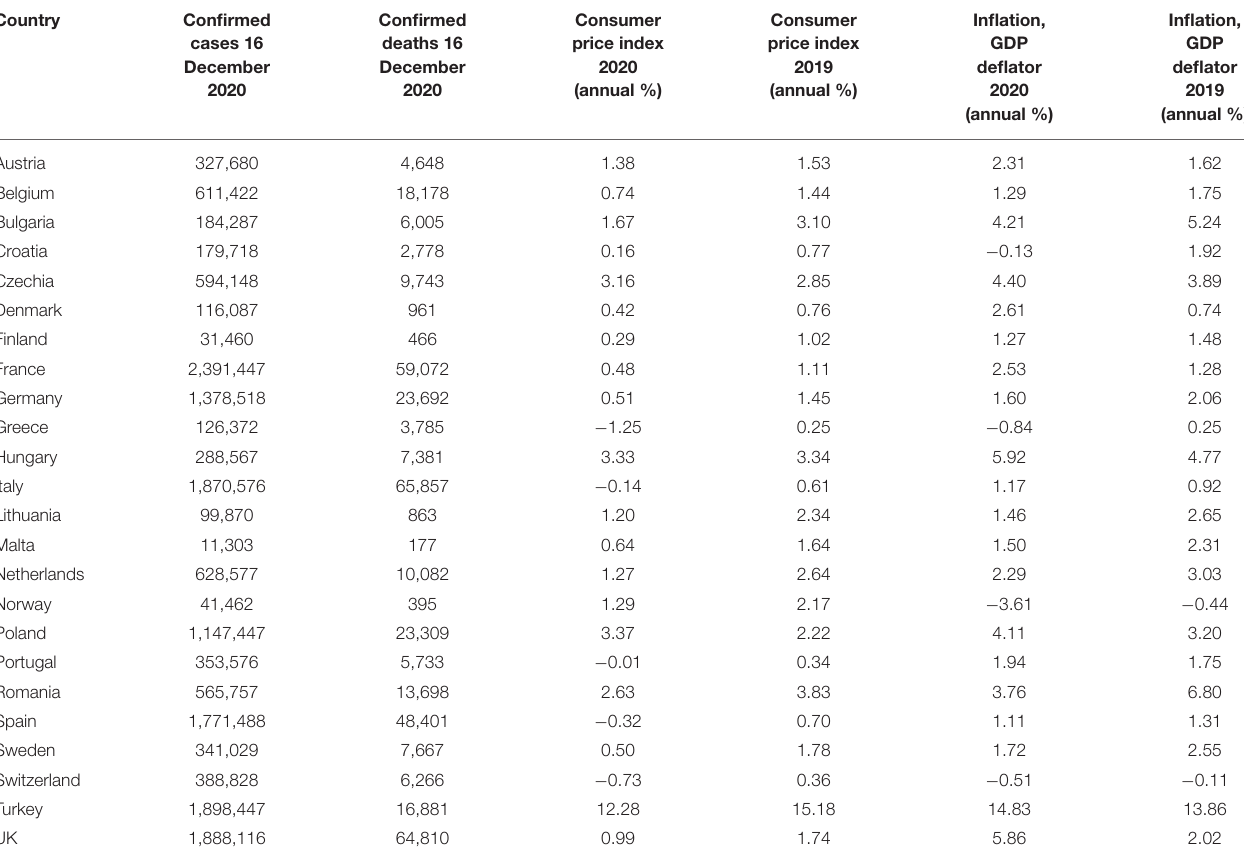
TABLE 6 | Cases of coronavirus disease 2019 (COVID-19), COVID-19-induced deaths, and consumer price indexes in Europe. Country